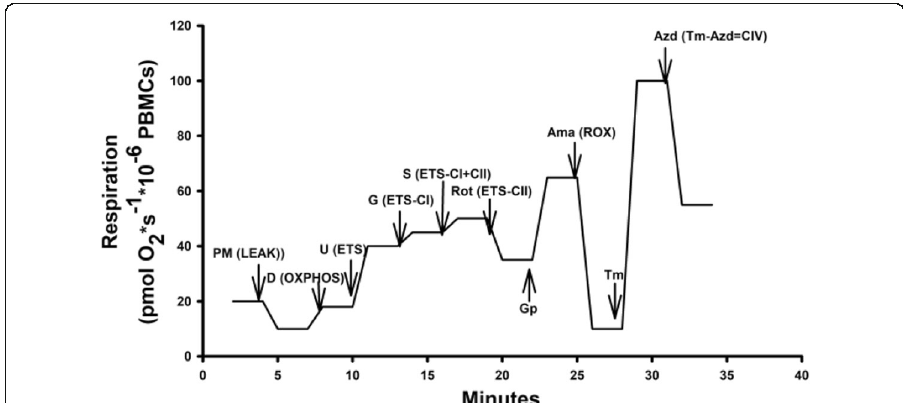
Fig. 2 Reference protocol. The figure represents a standard tracing to obtain various coupling states in permeabilized cells. This reference protocol provides a common reference for comparison of respiratory control in a large variety of tissues and cell types. Each arrow represents a point of an injection with the corresponding compound and respiratory state in